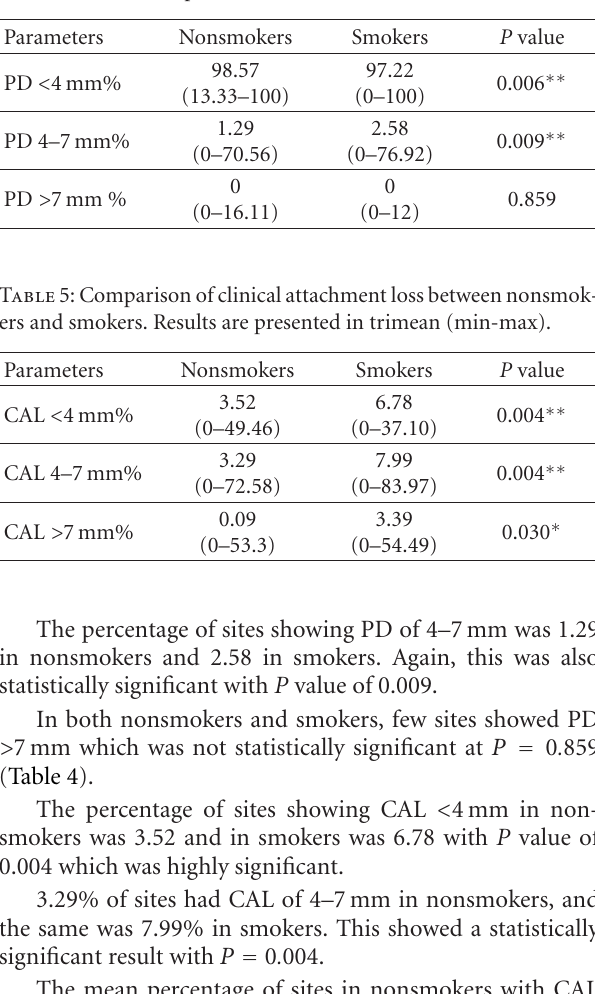
Table 8: Comparison of furcation between nonsmokers and smokers.